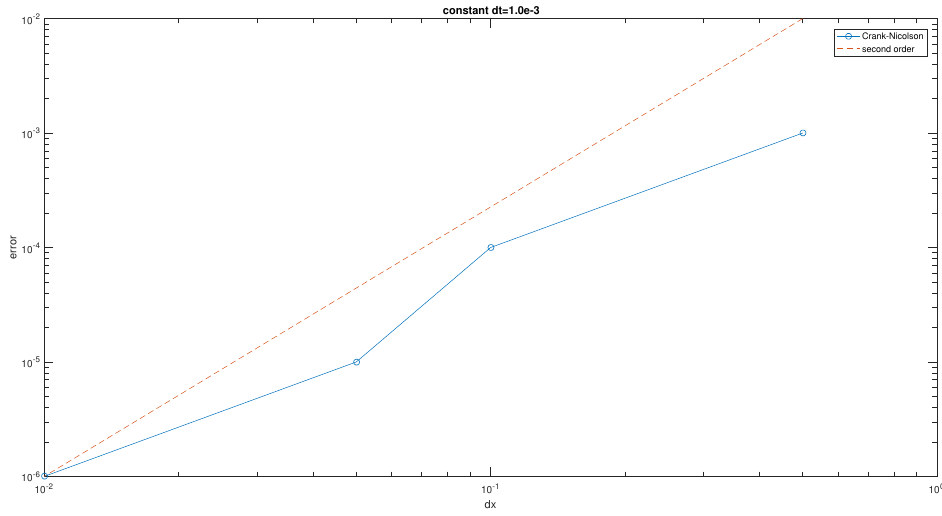
in L 1 -norm as a function of the u e u approx (cid:107) − (cid:107)